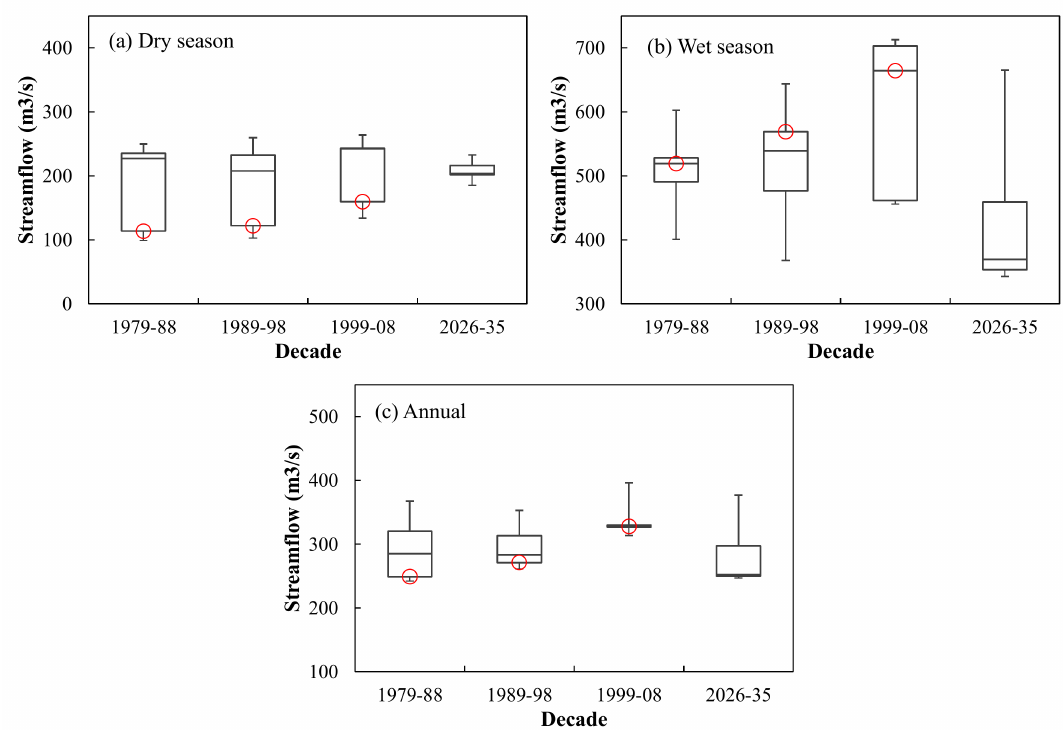
Figure 11. Box-and-whisker plot of ( a ) dry season, ( b ) wet season, and ( c ) annual streamflow simulated using high-resolution multi-model simulations for each decade in the baseline and near-term climates; the red circles represent mean streamflow simulated using observed